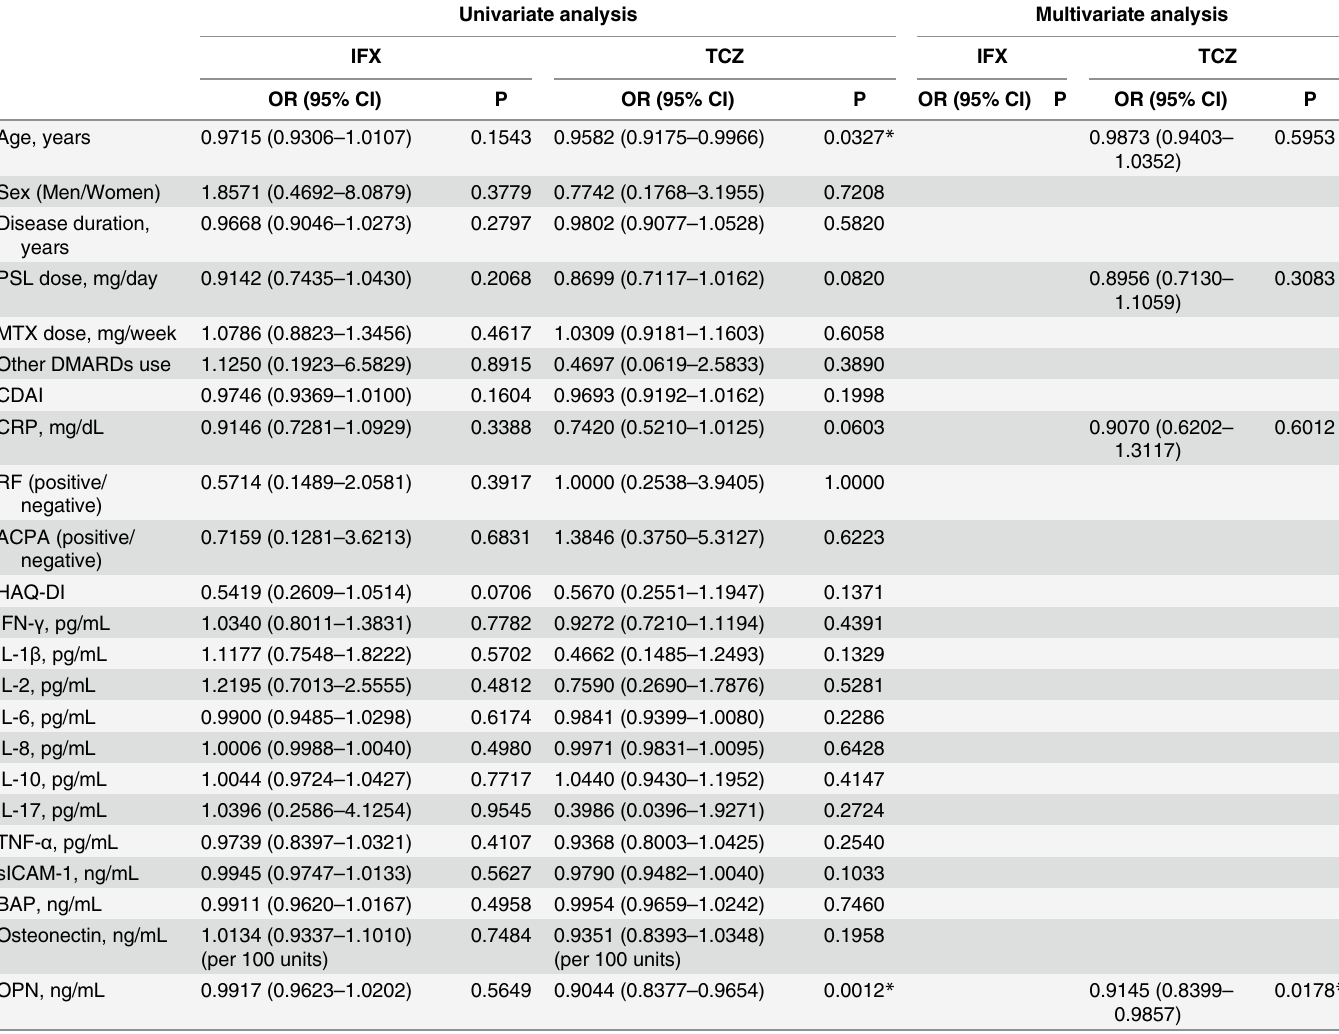
Table 2. Univariate and multivariate logistic regression analyses of baseline factors for CDAI remission at 1 year. Univariate analysis Multivariate